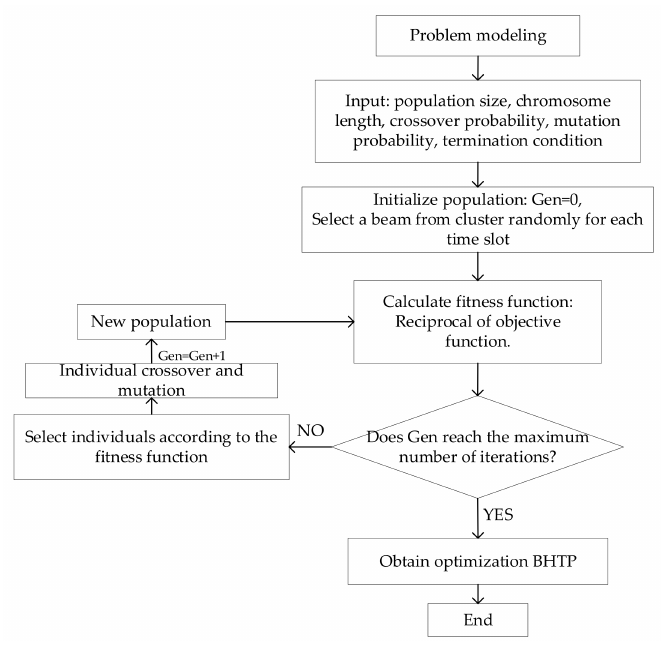
Figure 3. Process chart of beam hopping time plan optimization based on GA. Other parameters include the number of individuals in the initial population, the probability of crossover and mutation. They should be set appropriately to minimize the complexity while guaranteeing that the optimal solution can be obtained [37]. Finally, the dynamic time slots allocation based on GA for beam hopping is shown in Algorithm